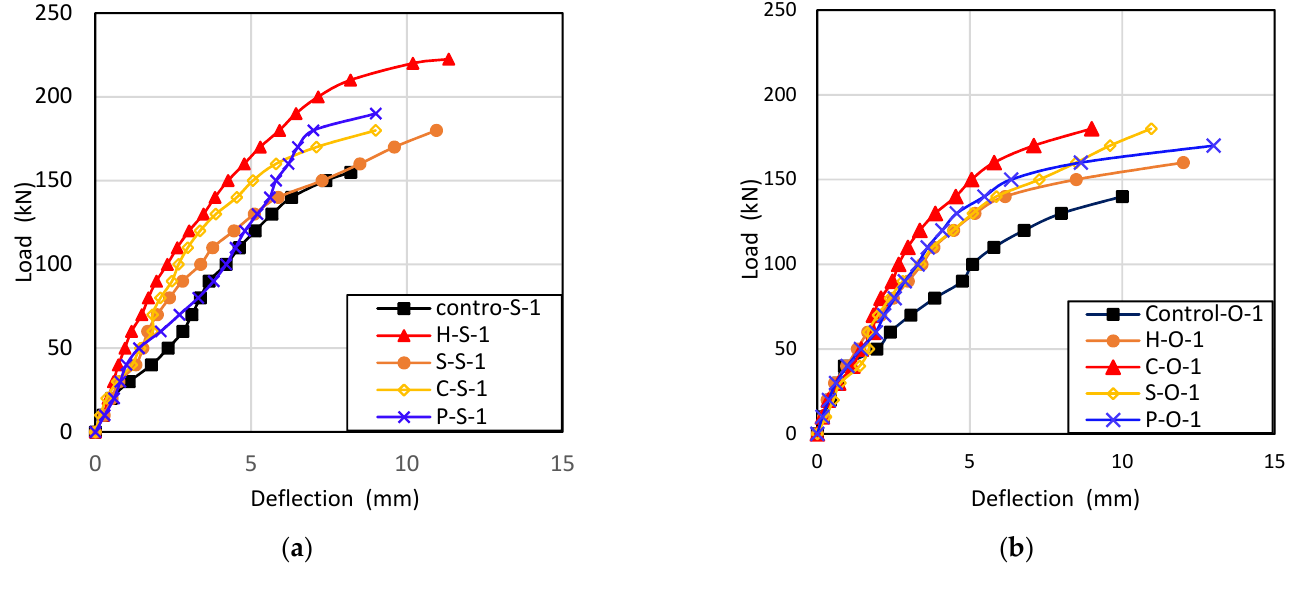
Figure 10. Load–Deflection with different types of fiber. ( a ) Solid slab; ( b ) Slab with opening. Table 8. Ultimate load of specimens for slab with